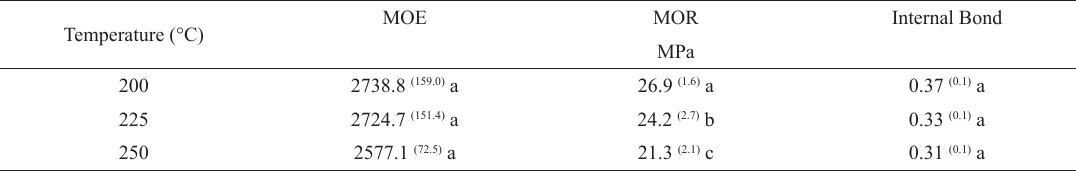
Table 8: Average values of MOE, MOR and Internal Bond based on the temperature applied to the MDF Temperature (°C)